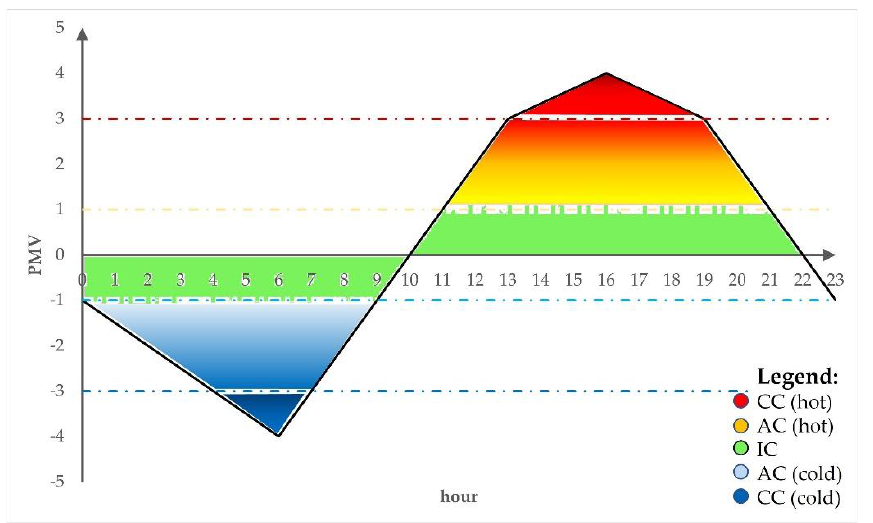
Figure 5. Example of an extreme daily trend of the PMV.